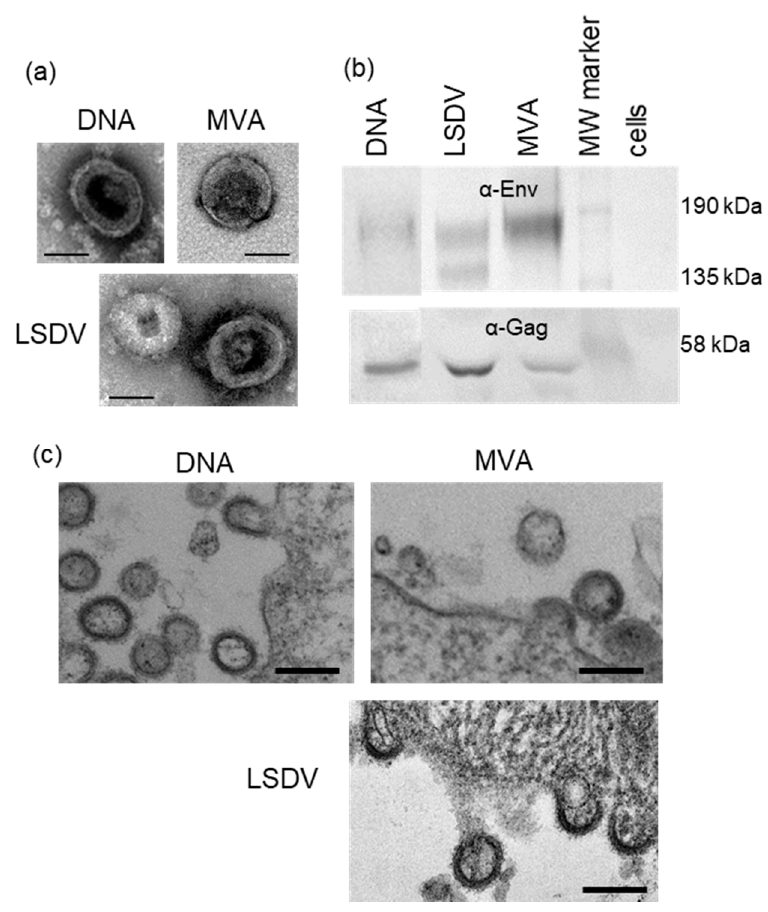
Figure 4. The in vitro formation of virus-like particles (VLPs) from cells transfected/infected with DNAGC5, MVAGC5, and LSDVGC5 vaccines. ( a ) The negative stain EM analysis of purified VLPs. Scale bar = 100 nm. ( b ) Western blotting of VLPs. Membranes were cut in half and the top half was probed with α -Env and the bottom was probed with α -Gag. ( c ) Electron micrographs of VLPs budding from cells transfected/infected with DNAGC5, MVAGC5, and LSDVGC5 vaccines. Scale bar = 200 nm.